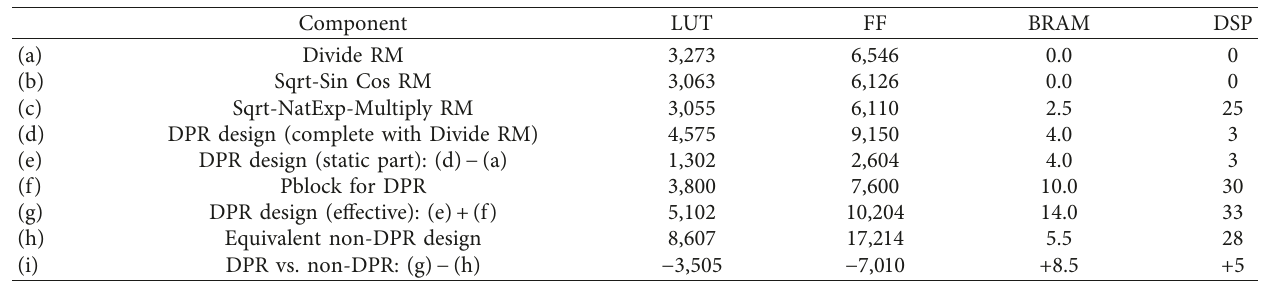
Table 3: Resource utilization in the EU-swapping experiment.